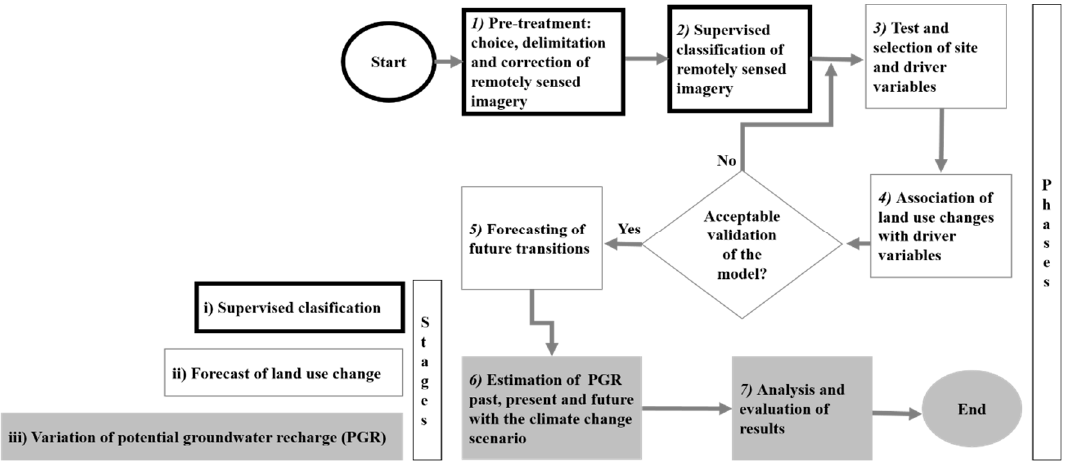
Figure 2. Methodological scheme for estimating potential groundwater recharge.